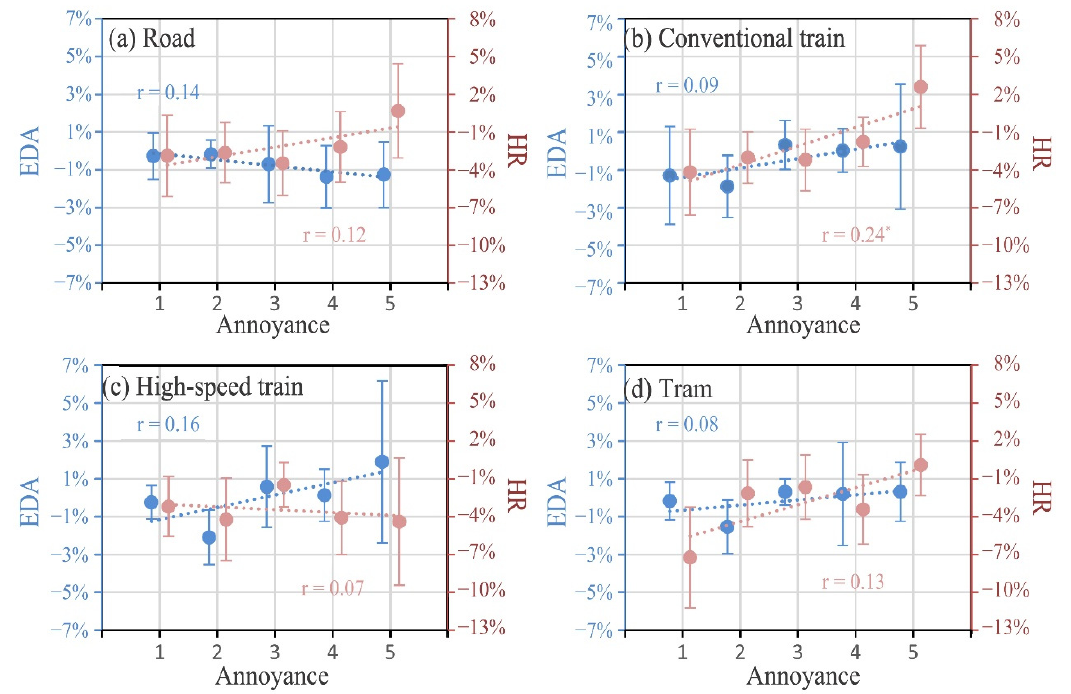
Figure 11. Relationship between psychological response (annoyance) and physiological responses in four traffic sound groups: (a) road traffic; (b) conventional train; (c) High-speed train; (d) tram. * represents significant correlation at 0.05 level.